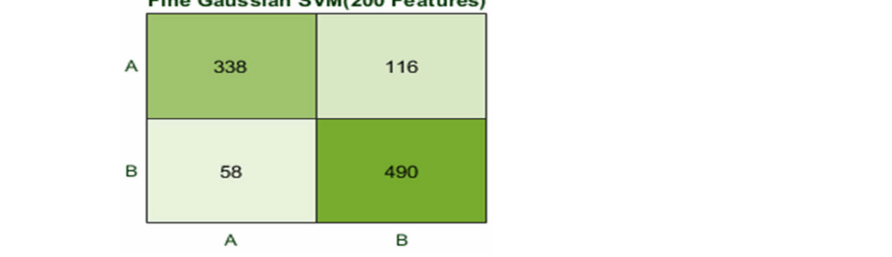
Figure 14. Confusion matrix for FG(SVM) with 200 features and using 10-fold results.